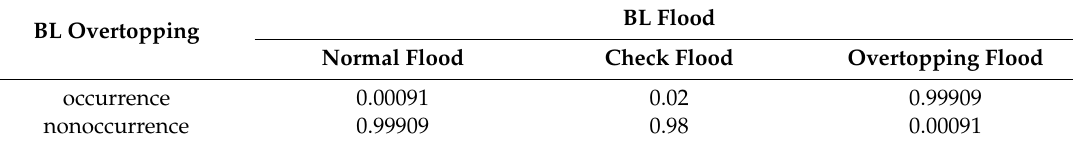
Table 3. The control probability table of Bala (BL) Overtopping